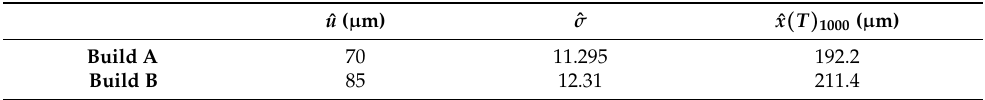
Table 5. Cut-off ( ˆ u ) and scale (ˆ σ ) parameters, as well as the characteristic maximum defect size for 1000 specimens ˆ x ( T ) 1000 .